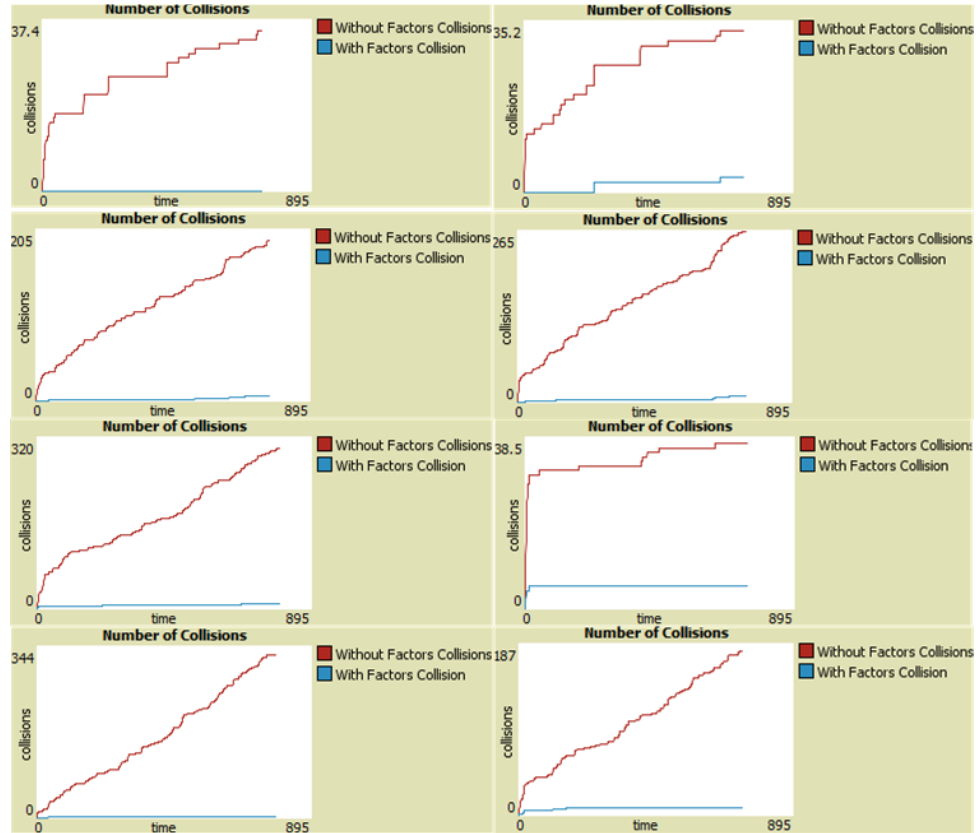
Figure 12. Simulation Results with and without Multi Factors. Table 4. Experiments Results Using Net-Logo Simulation with Inputs (EF = Environmental